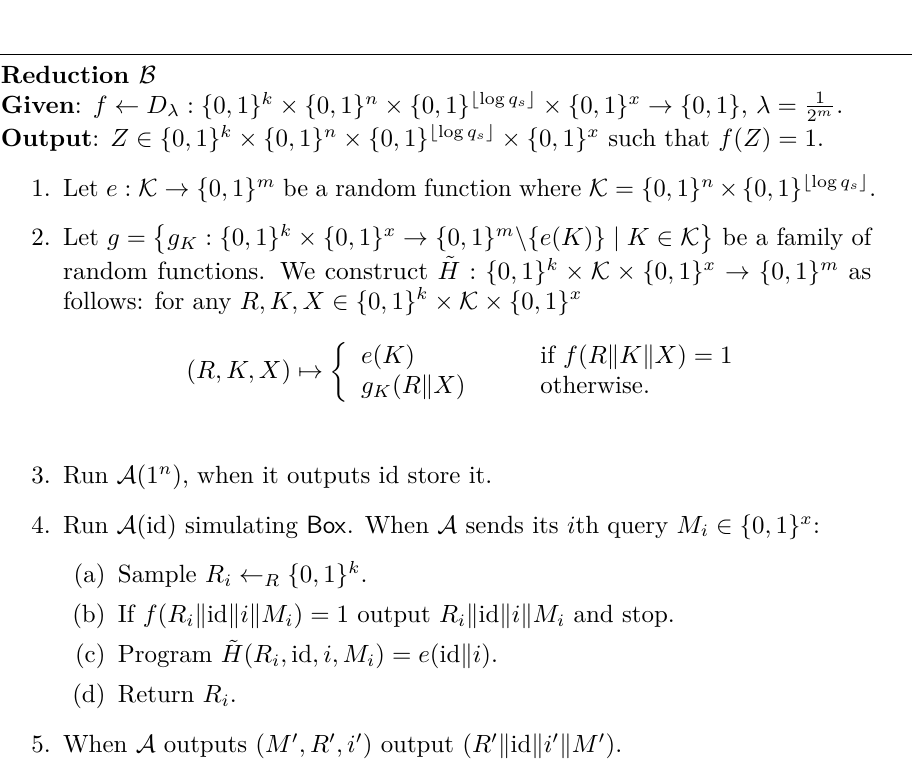
Figure B.1: Reducing Avg-Search to nM-eTCR